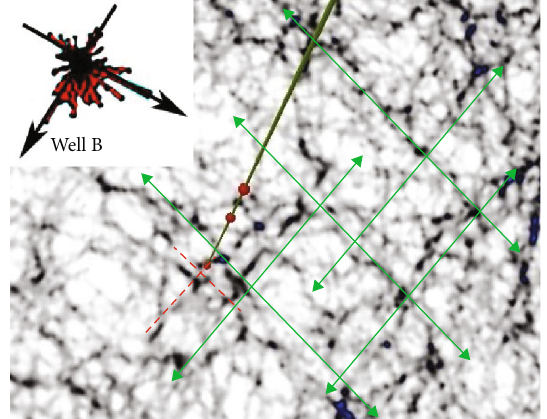
Figure 12: Prediction map of Well B of the fracture azimuth predicted result compared with imaging